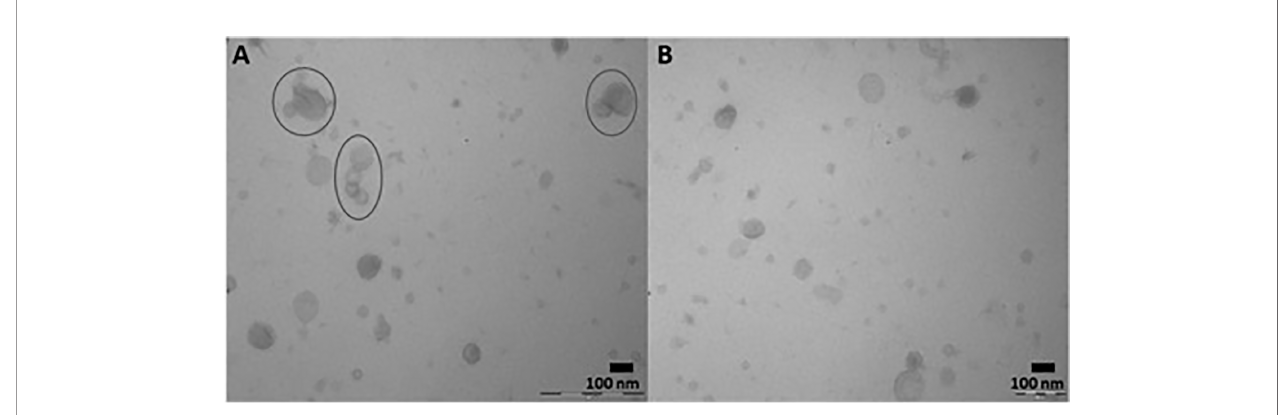
FIGURE 1 | Representative developed TEM micrographs identifying extracellular vesicles secreted by C. daubneyi in vitro through DC and SEC isolation. (A) DC puri fi ed samples with visible aggregation of vesicles (circled) (B) SEC puri fi ed samples demonstrating a reduction in